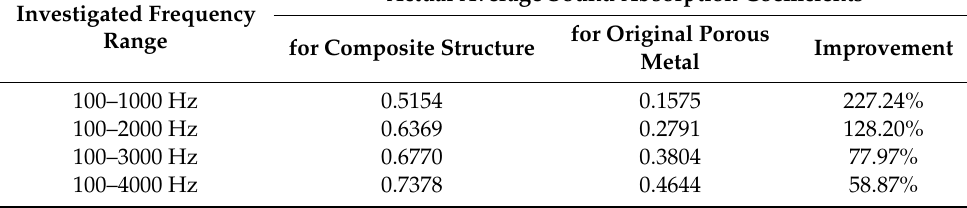
Table 4. Actual average sound absorption coe ffi cients of the composite sound-absorbing structures and those of the original porous